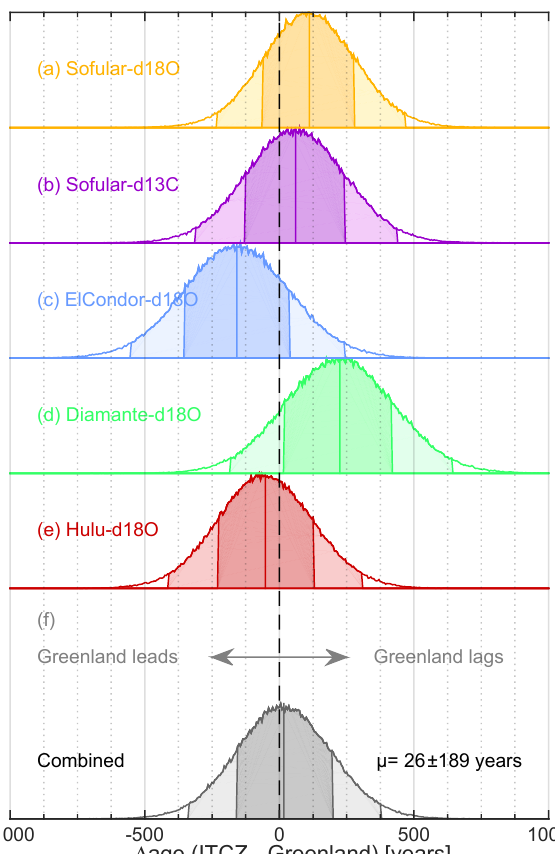
Figure 15. Average lead–lag between the onset of DO events in the speleothems and NGRIP. Each panel (color) shows the PDF for the lead–lag of the onset in the speleothem compared to NGRIP, averaged over all investigated DO events (i.e., excluding the GS-3 dust peak, H2). Panel (f) shows the PDF of the average of all DO events and speleothems. The dark and light shading of the PDF in each panel indicates 68.2% and 95.4%